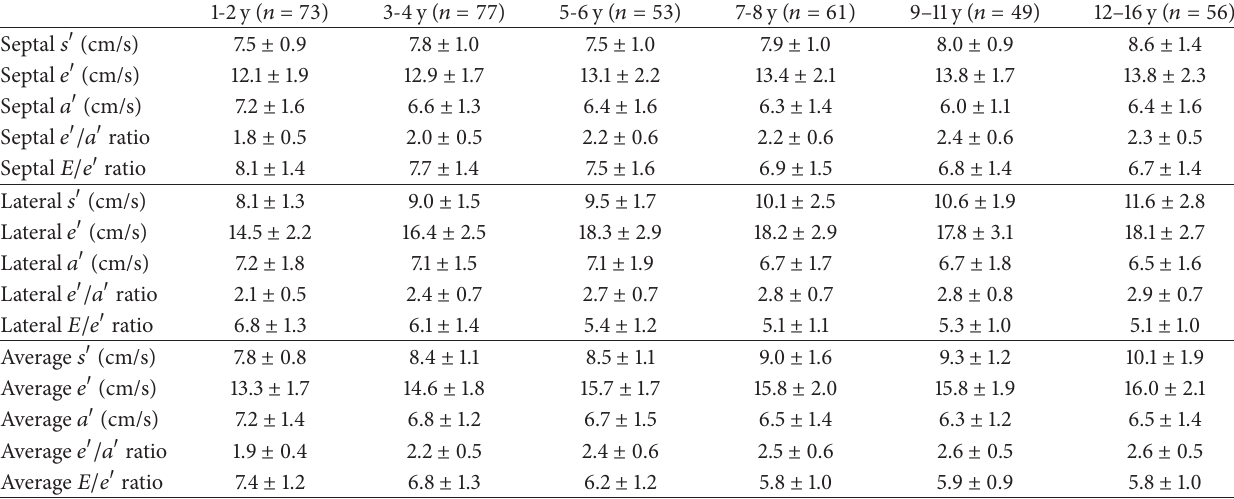
Table 3: Reference ranges of left ventricular longitudinal indexes according to age class, expressed as mean ± standard